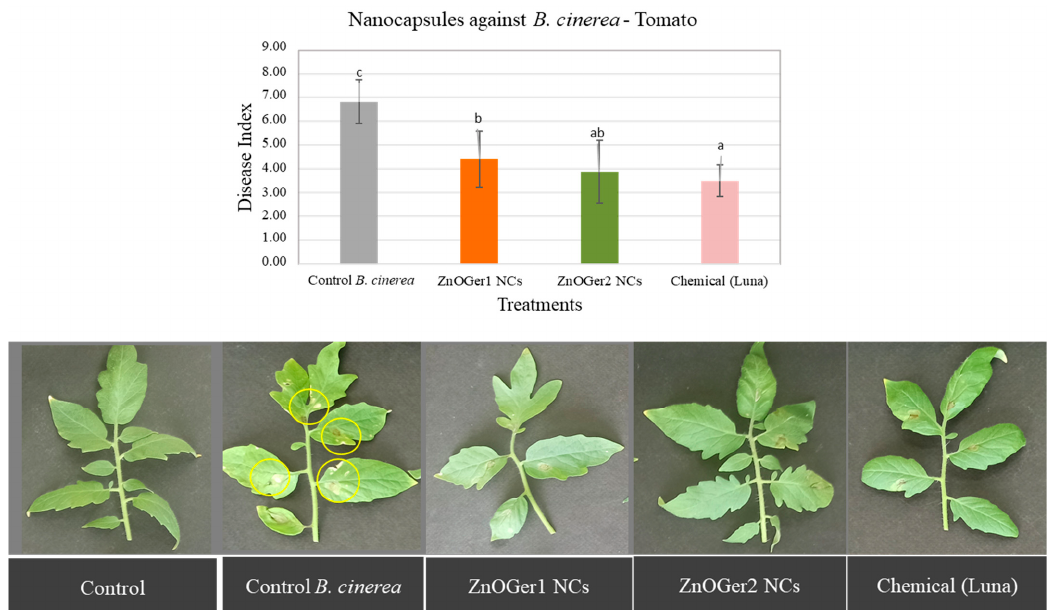
Figure 7. Effect of ZnOGer1 NCs and ZnOGer2 NCs on the severity of disease caused by B. cinerea on tomato leaves in pots under controlled conditions. B. cinerea control plants were inoculated only with the pathogen (control B. cinerea ). The disease was assessed according to the disease index (DI) [9] after 96 h. The experiment was repeated three times. Different letters indicate significant differences according to Tukey’s test at p ≤ 0.05. Error bars represent standard deviation.